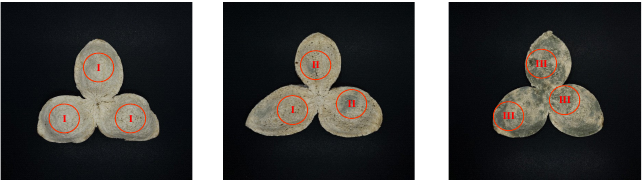
Figure 4. Moldy PCRC samples collection areas graded according to their degree of mold. ( I ) non-moldy in area; ( II ) lightly moldy in area, ( III ) moderately moldy in area.